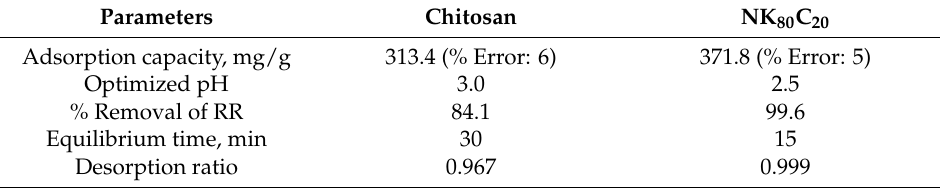
Table 2. Comparison of adsorption performance between chitosan and NK 80 C 20 .